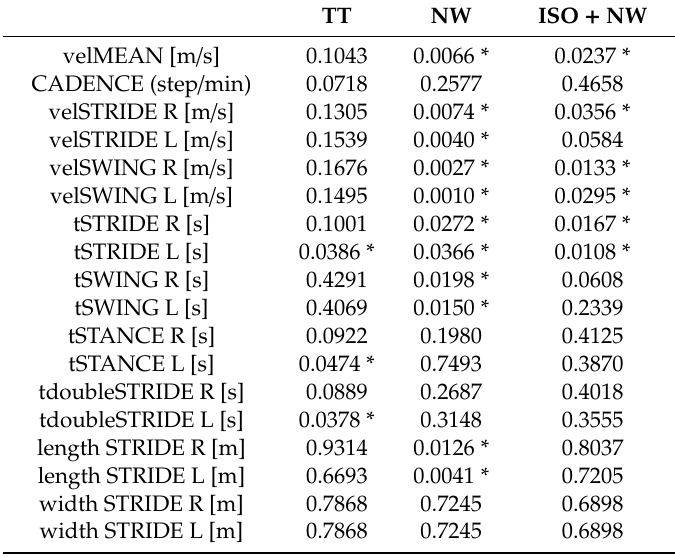
Table 5. Repeated-measures ANOVA for the time parameters of gait, taking into account the type of training and the test